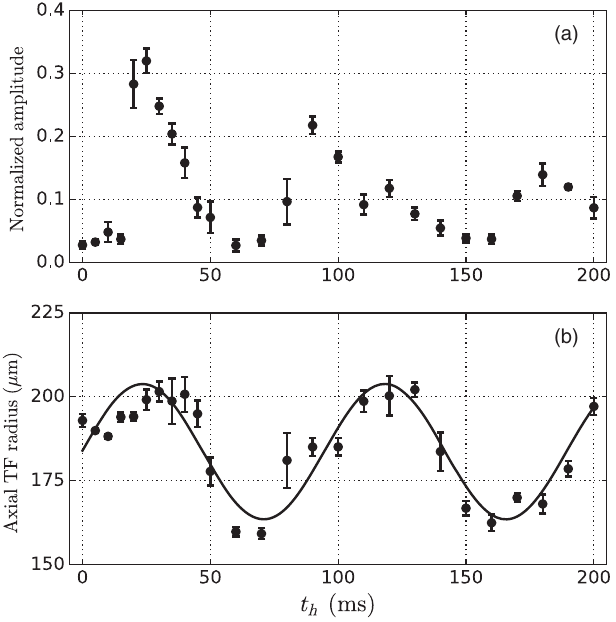
FIG. 5. Growth and suppression of the Faraday pattern. (a) The normalized amplitude of the primary spatial frequency in the FFT spectrum as a function of t . (b) The fitted axial Thomas-Fermi h radius of the central region over the same time interval is shown by the filled circles. The solid line is a sinusoidal fit correspond- ing to a period of 95 ms. For these data, ω ¼ ð 2 π Þ 950 Hz and ¼ 5 t m